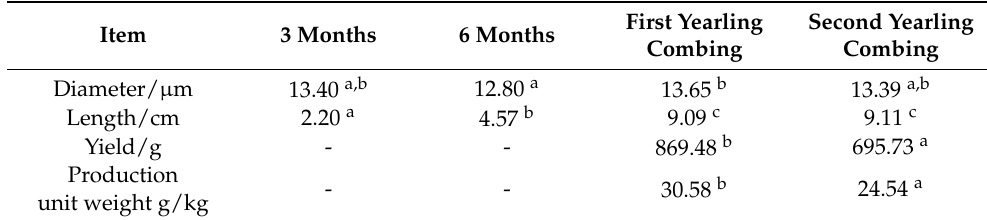
Table 4. Cashmere performance at different time